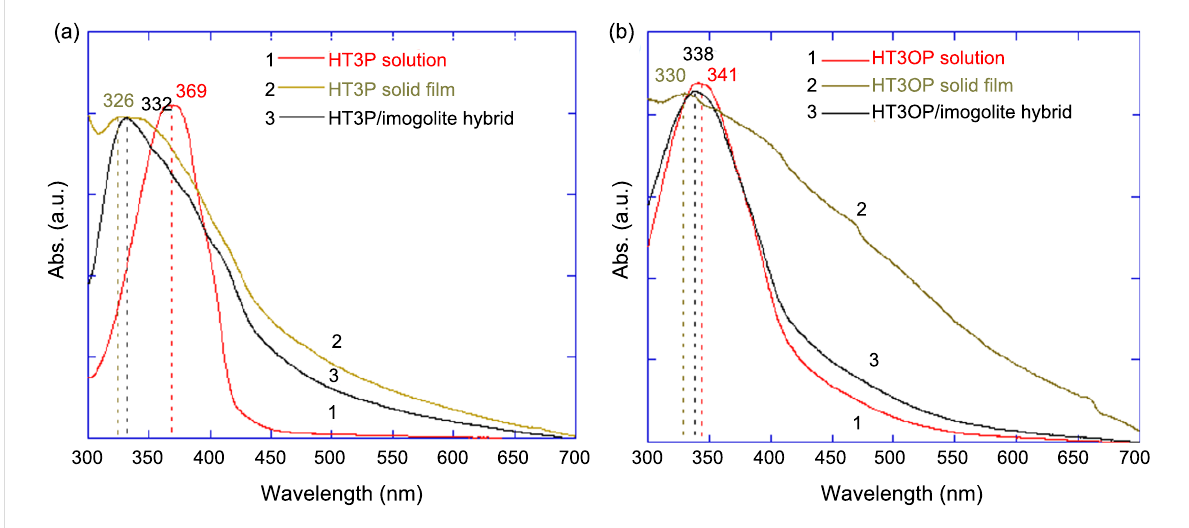
Figure 17: Normalized solid-state (cast film), imogolite hybrid and solution absorption spectra of (a) HT3P and (b) HT3OP. Reprinted with permission from W. O. Yah et al., Bull. Chem. Soc. Jpn. 2011, 84, 893–902 [60]. © 2011, The Chemical Society of Japan.